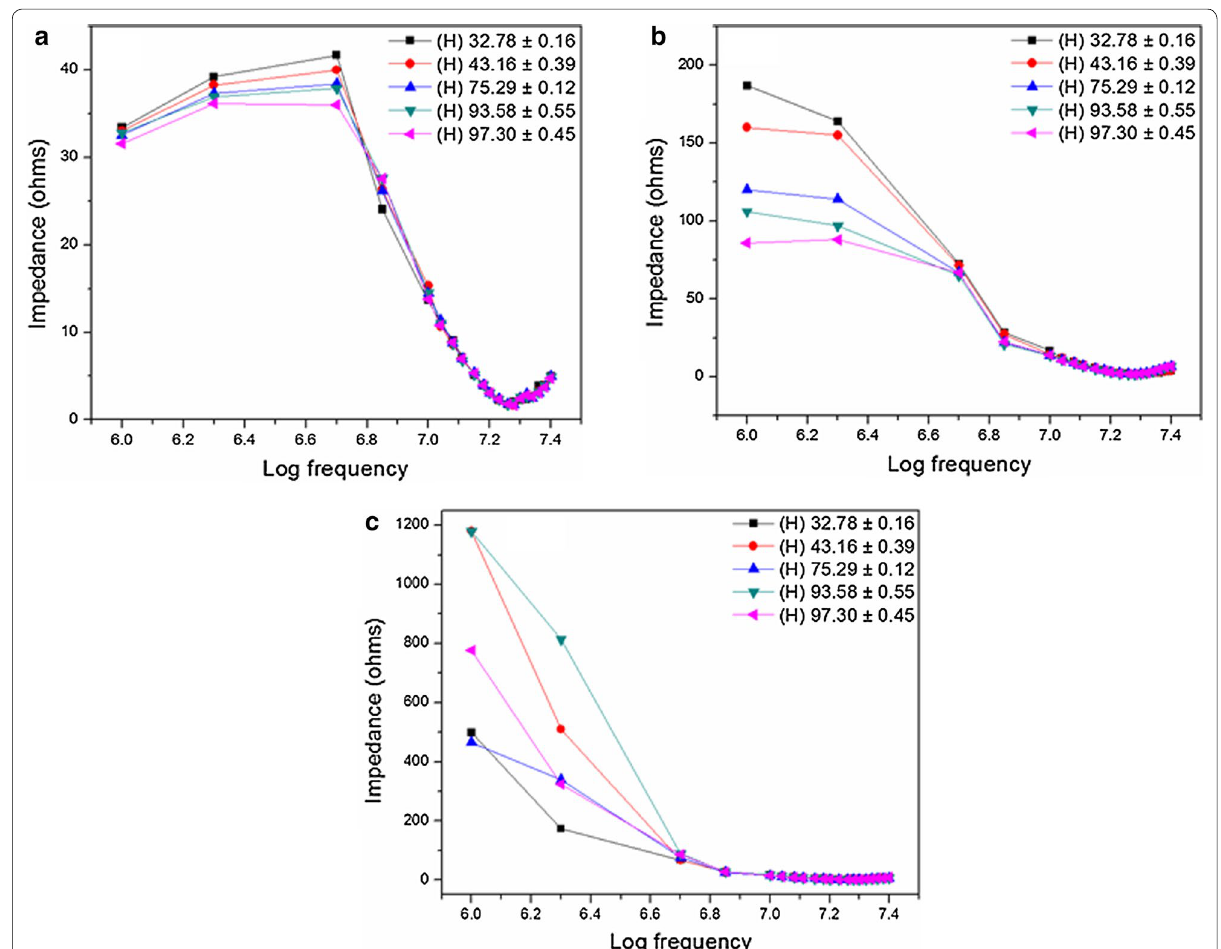
Fig. 11 Capacitive behavior of a PAni film, b Pd incorporated PAni film and c Pd only sensors for